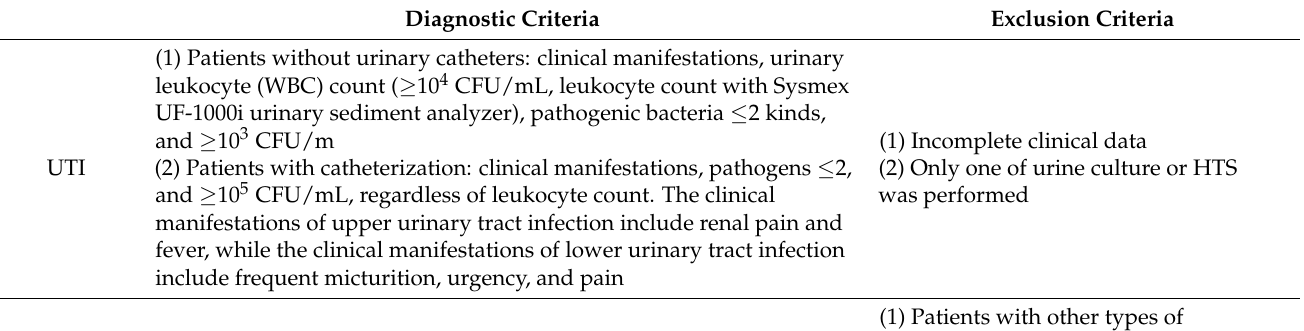
Table 1. Criteria for diagnosis and